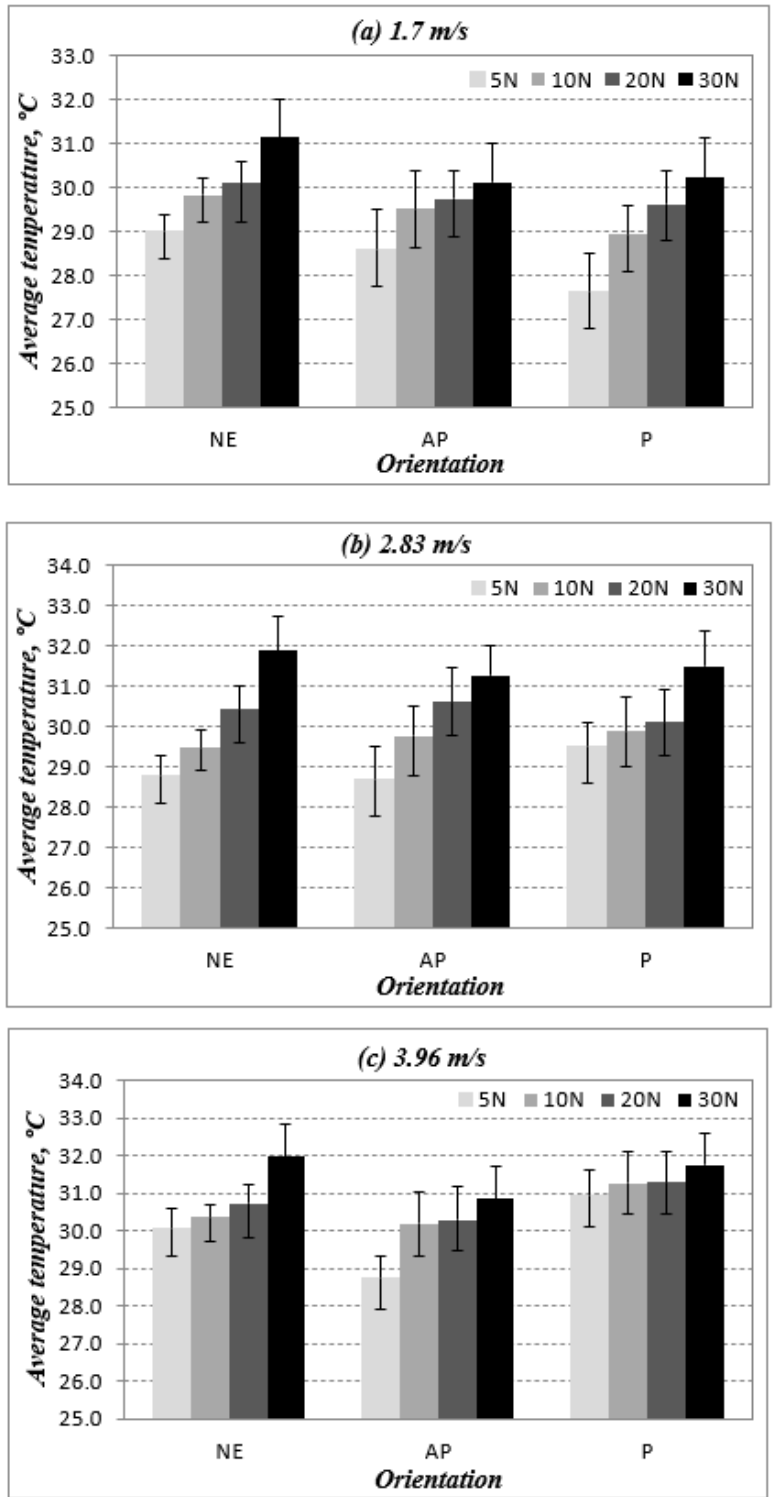
Figure A7. Average temperature for the two different fibre orientations (AP and P) and neat epoxy (NE) subjected to different applied normal loads at different counterface sliding velocities.